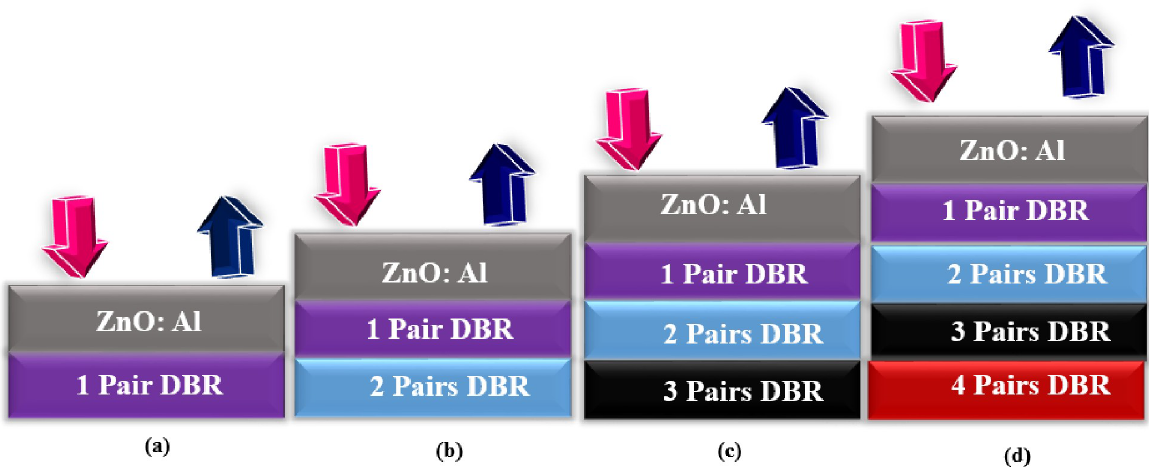
Fig 4. Geometry of the DBR pairs after cooperating it on the solar cell bottom area (a) single pair (b) double pair (c) three pair and (d) four pair, where each pair is composed of (Si/SiO 2 ).